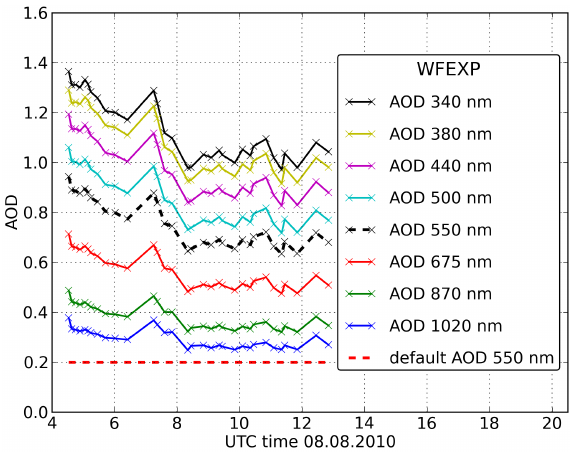
Figure 2. AERONET measurements of AOD at Tõravere on 8 Au- gust 2010 for seven SW wavelengths (nm). The AOD550 derived from these measurements (black dashed line) and the default clima- tological AOD550 at Tõravere (red dashed line) are also shown in the figure. Data are not available after 14:00UTC due to the pres- ence of clouds.